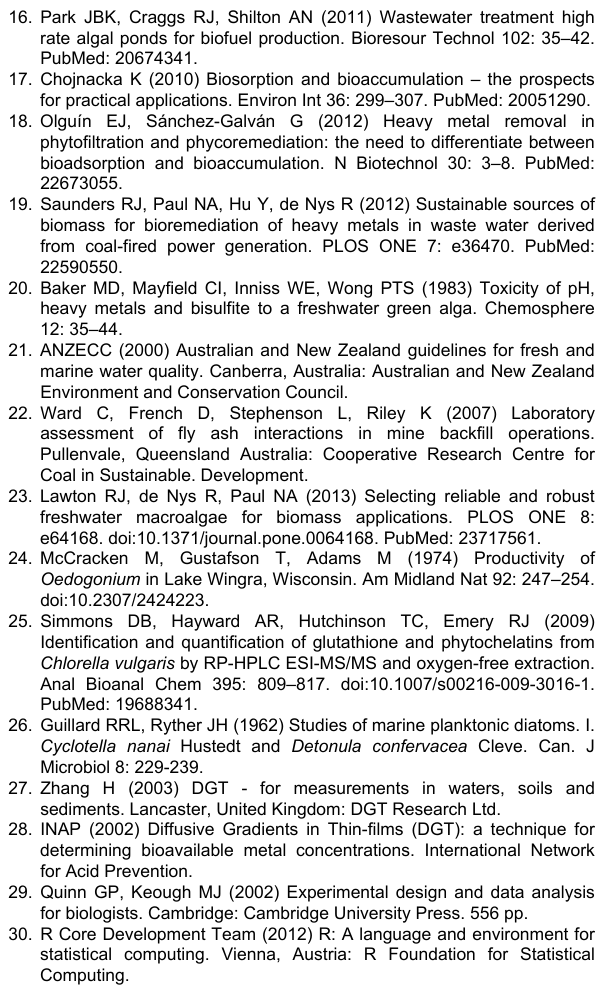
Table S2. Repeated Measures Analyses of Variance of element concentrations in Oedogonium sp. biomass cultured in Ash Dam Water under different CO regimes. Significant main effects or interactions (P < 0.05) are highlighted in bold.